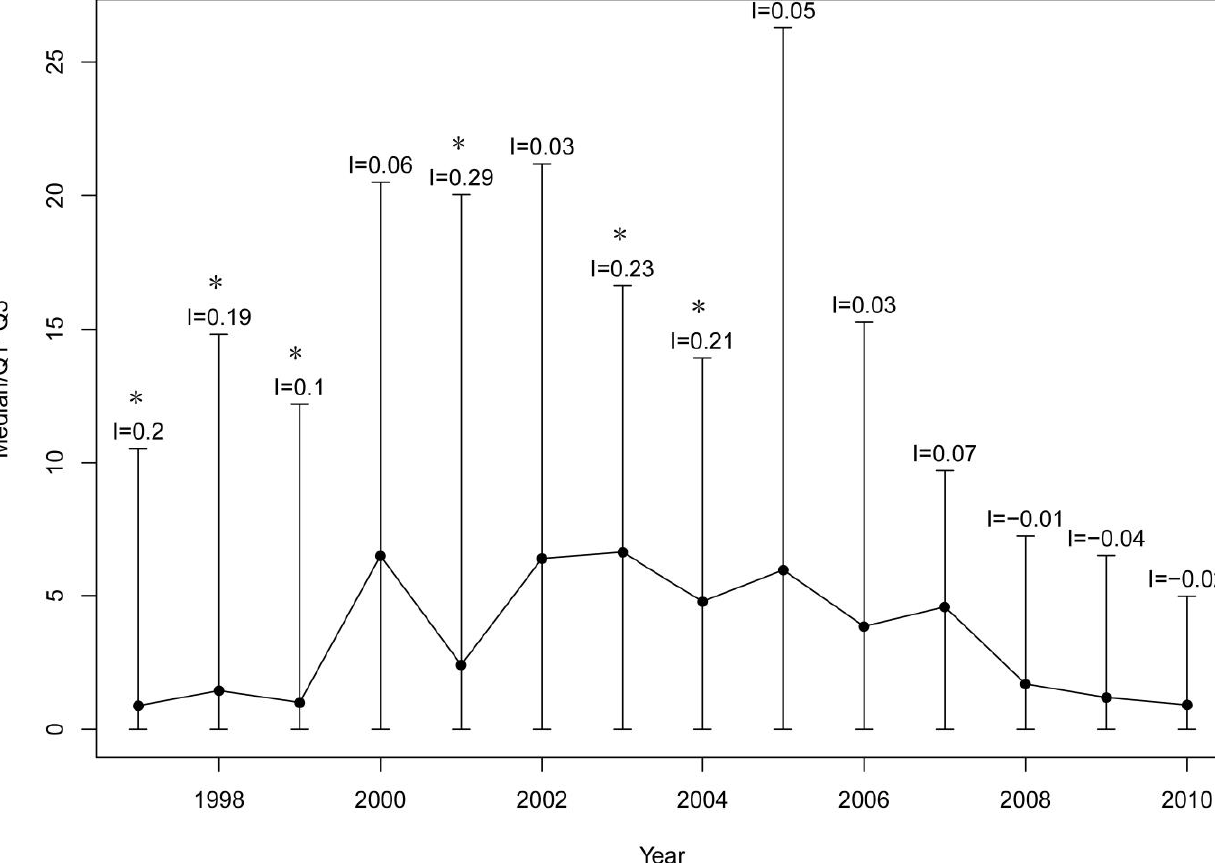
Figure 2. The prevalence (cases/10,000) trend of schistosomiasis and its global spatial autocorrelation, Anhui Province during 1997–2010. The black spot represented the median prevalence of schistosomiasis; the vertical line represented the interquartile range (IQR); I: the Global Moran’s I ; * : p < 0.05 ( p- value for the Global Moran’s I